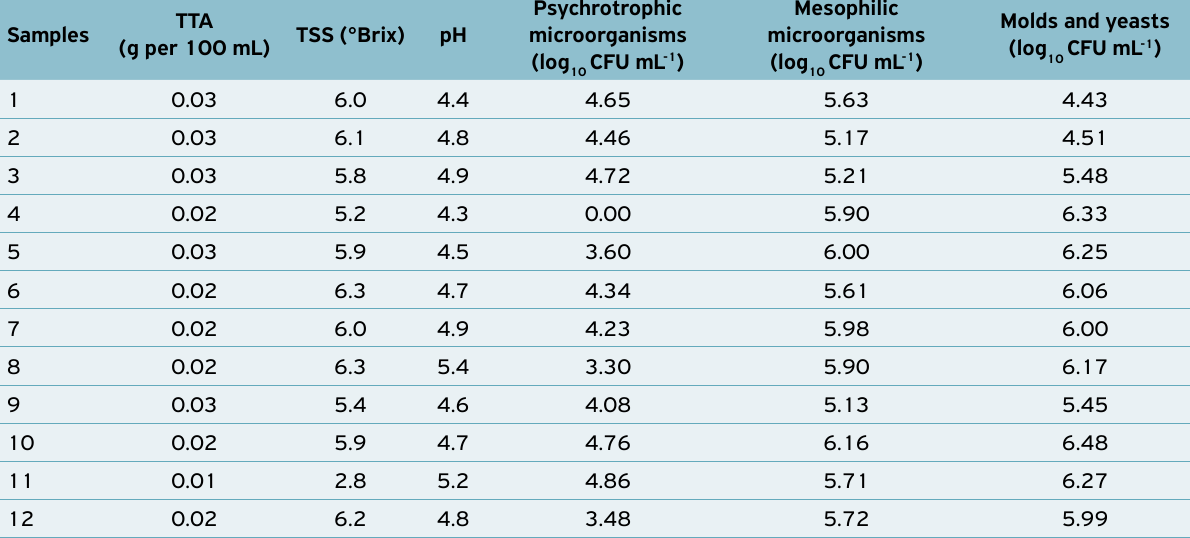
Table 1. Means of physicochemical parameters and counts of microorganisms (log manually extracted by street